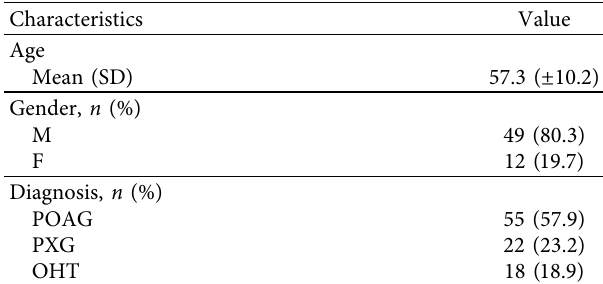
Table 1: Demographic and clinical characteristics of patients underwent selective laser trabeculoplasty (SLT) at Menelik II Hospital Glaucoma Clinic, 2018.